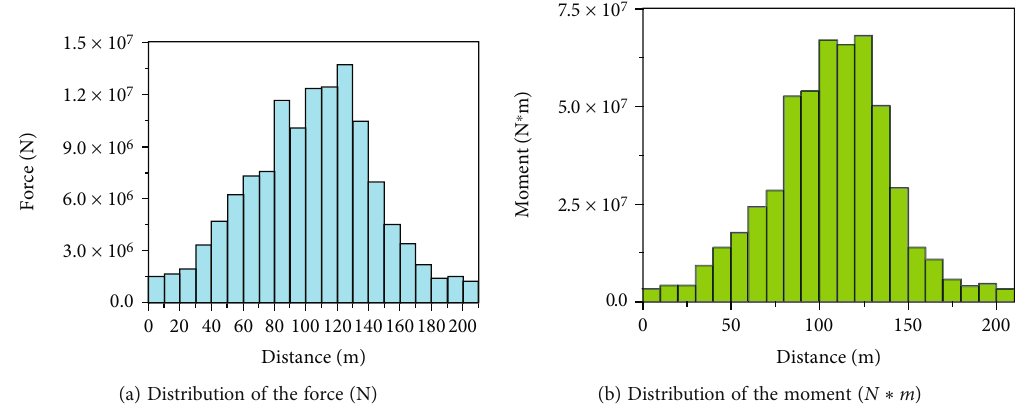
Figure 9: Stable load distributions on rigid retaining wall along the